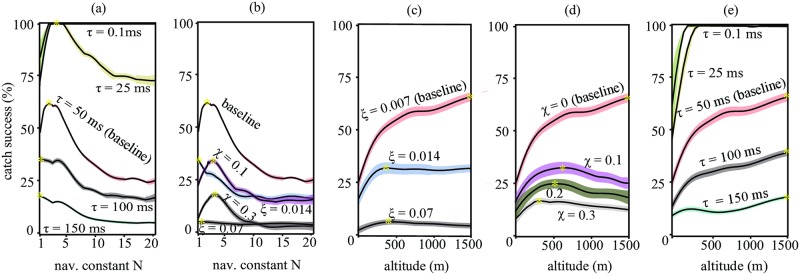
Relationship between catch success and various model parameters.Graphs depict results for non-smooth maneuvering prey, because in this condition the high-speed stoop with a low N shows the most marked increase in catch success for the falcon. The upper bounds in values for reaction times and errors in vision and control are chosen such that they are different enough to show substantial variation in simulation results, but remain low enough to allow for capture. (a) Maximum catch success as a function of N in the baseline model, for smaller (τ = 0.1ms & 25ms) or larger (τ = 100ms & 150ms) response delays, assuming the optimal attack position. The margins depict the 95% confidence intervals of the GAM. The asterisks denote the global optimum with respect to the x-axis. (b) Maximum catch success as a function of N for different visual (ξ) and control error (χ). (c) Maximum catch success as a function of altitude, for the baseline and for increased error in vision. (d) Maximum catch success as a function of altitude for various values of control error. (e) Maximum catch success as a function of altitude, for various values of response delay τ.